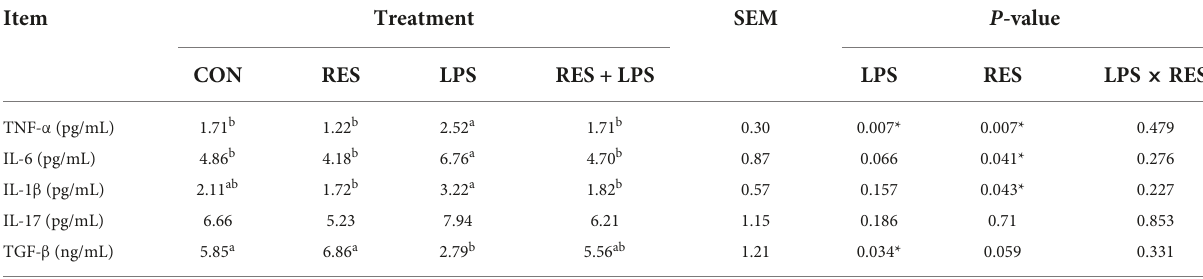
TABLE 6 Effect of dietary resveratrol supplementation on cytokine secretion in jejunal mucosa of yellow-feathered broilers with lipopolysaccharide 1